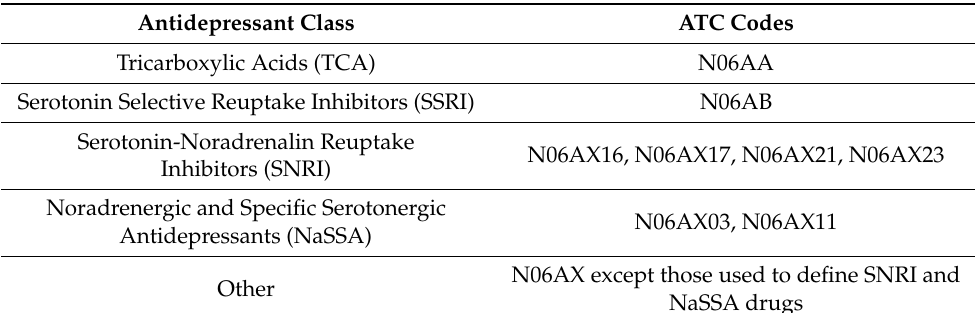
Table A2. ATC codes used to define antidepressant medicine.